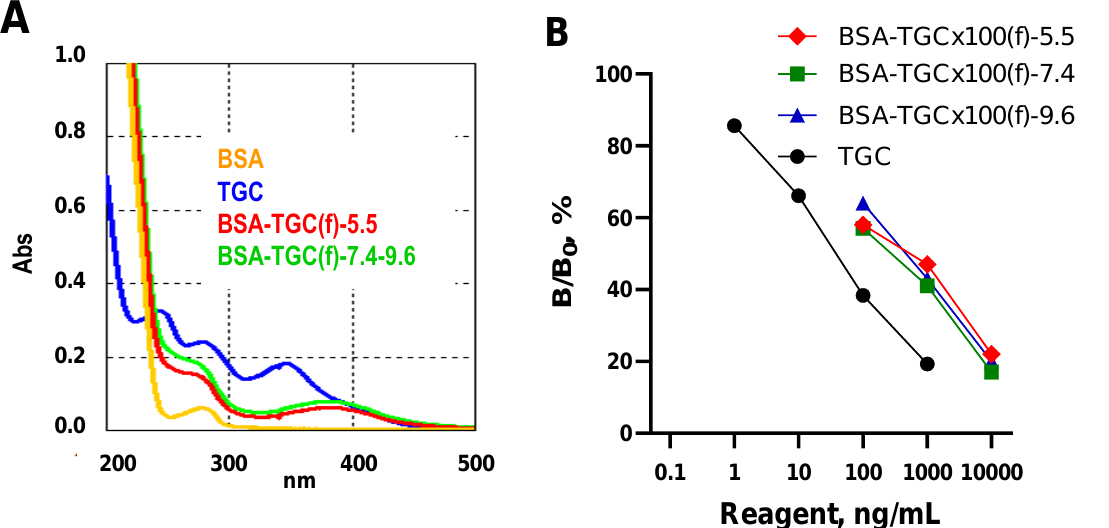
Figure 1. ( A ) The UV spectra of protein carrier BSA, hapten TGC, and resultant conjugate BSA-TGC(f). BSA and conjugate concentrations were 0.1 mg/mL, and TGC concentration was 0.01 mg/mL in water. ( B ) Inhibitory activity of prepared conjugates in ELISA using #32 antibody and TF(pi)-CTC as a coating antigen [15].